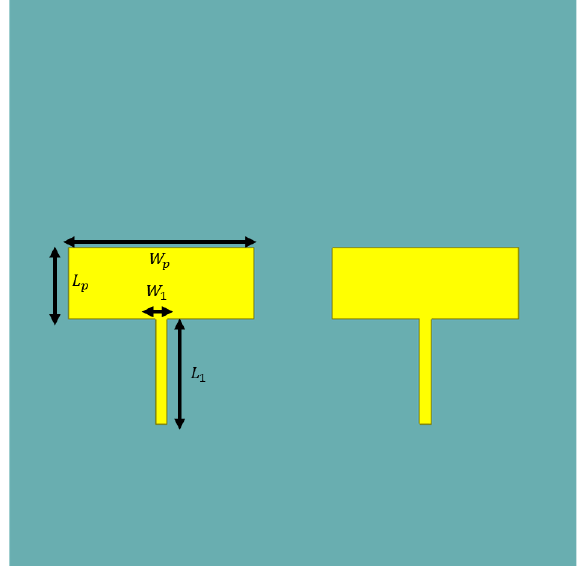
Figure 5. The initial design of the proposed chip antenna.